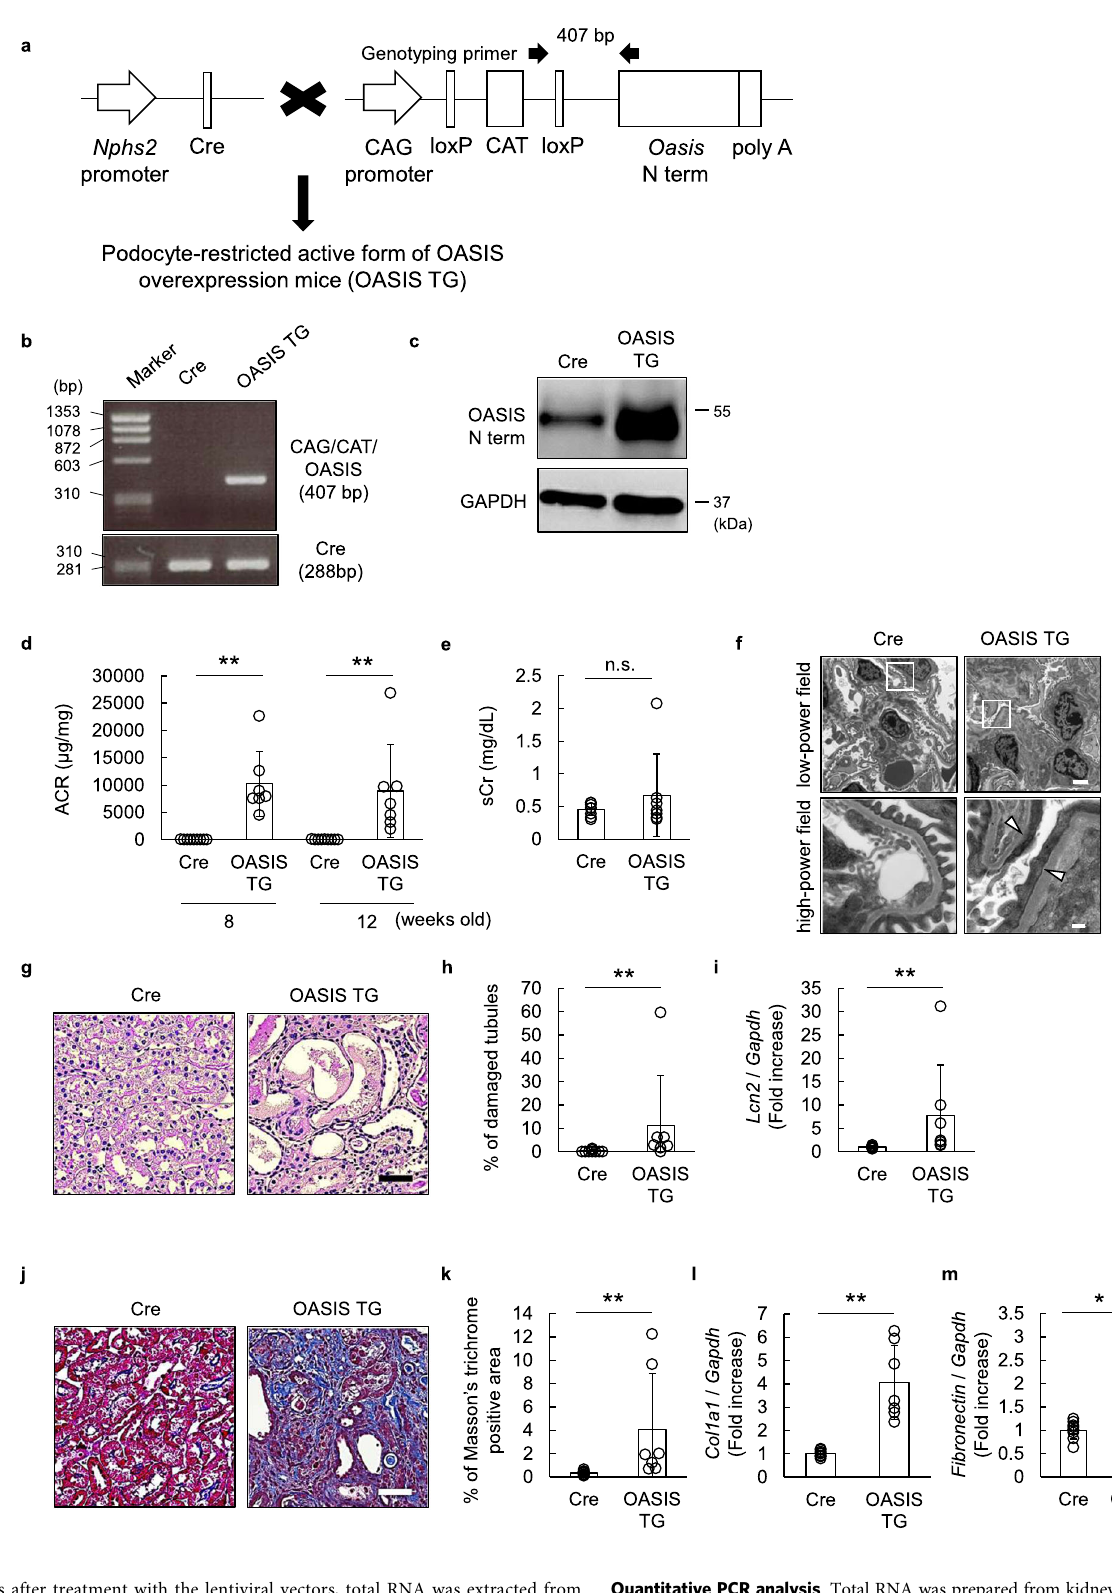
hours after treatment with the lentiviral vectors, total RNA was extracted from the OASIS-overexpressing podocytes, using the RNeasy ® mini kit (Qiagen, Venlo, Netherlands). Gene expression was analyzed using the SurePrint G3 Mouse GE v2 8 × 60 K Microarray (Agilent Technologies, Santa Clara, CA, USA). The threshold was set to >2.0 or <0.5 times, and q < 0.1, to extract can- didate downstream genes of OASIS, whose proteins could be secreted into the extracellular